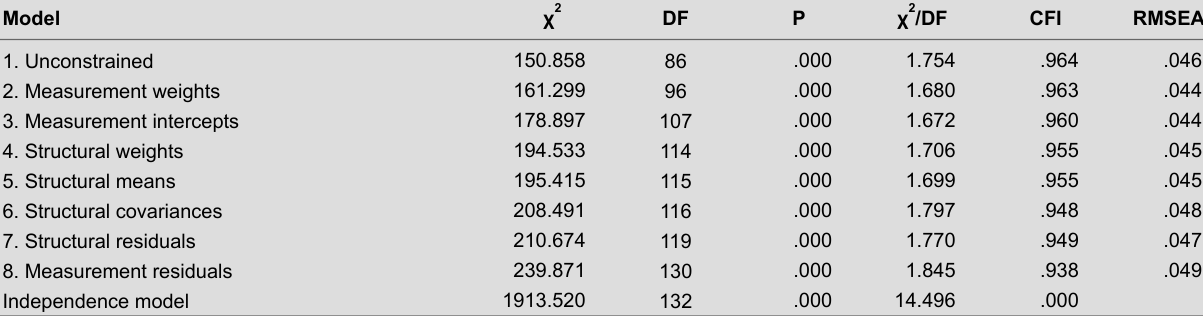
Fit Indices of Invariance Across